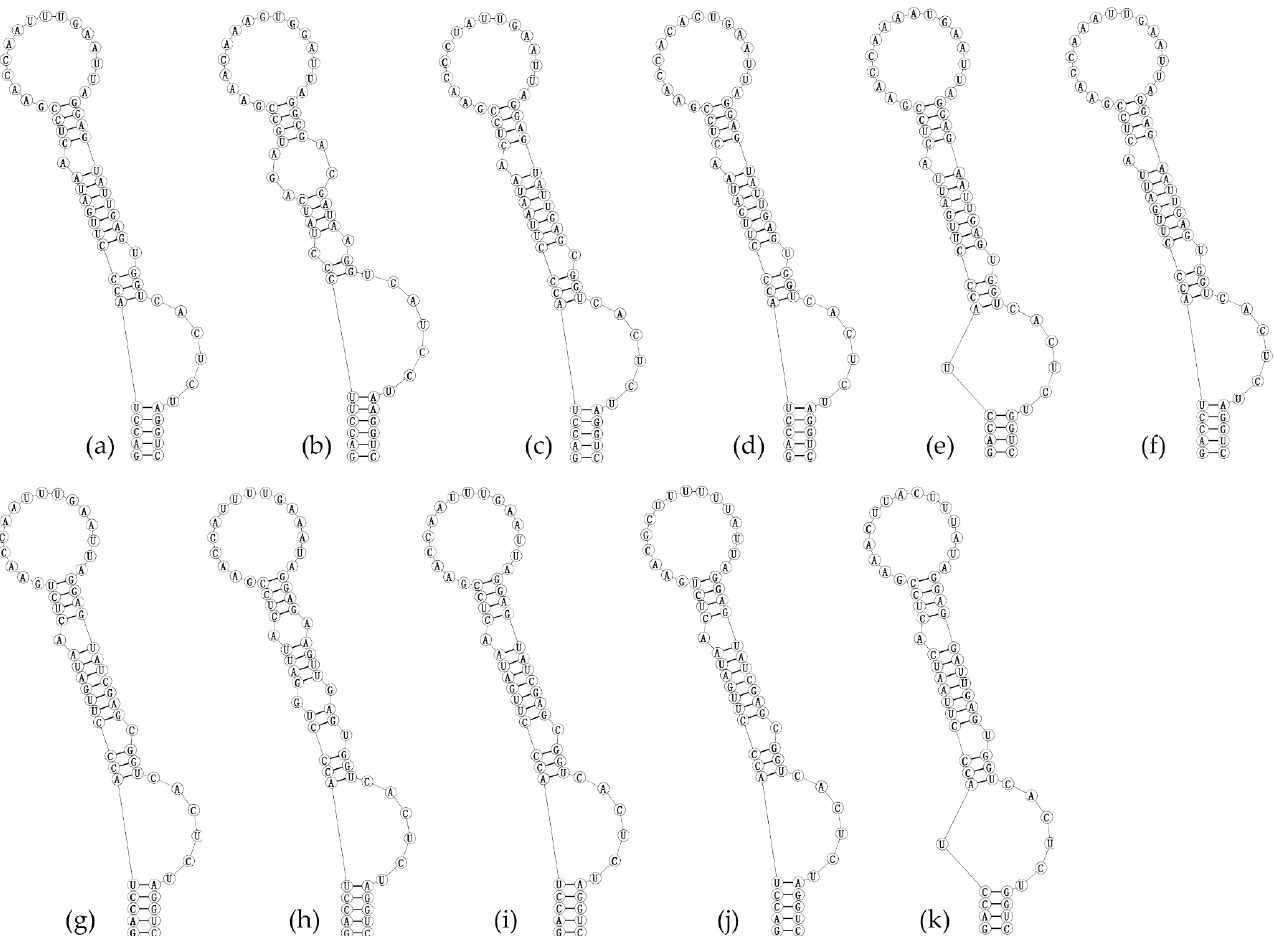
Figure 5. D1 –D1′ helices of 11 representative strains of Nodosilinea . ( a ) N. hunanesis ZJJ01. ( b ) N. conica strain SEV4-5-c1. ( c ) N. epilithica str. Kovacik 1990/52. ( d ) N. nodulosa PCC 7104. ( e ) N. signiensis USMFM. ( f ) N. svalbardensis 3220. ( g ) N. alaskaensis T21. ( h ) N. bijugata KOVACIK1986/5a. ( i ) N. chupicuarensis PC471. ( j ) N. radiophila TM S2B clone cl3. ( k ) N. ramsarensis KH-S S2.6.